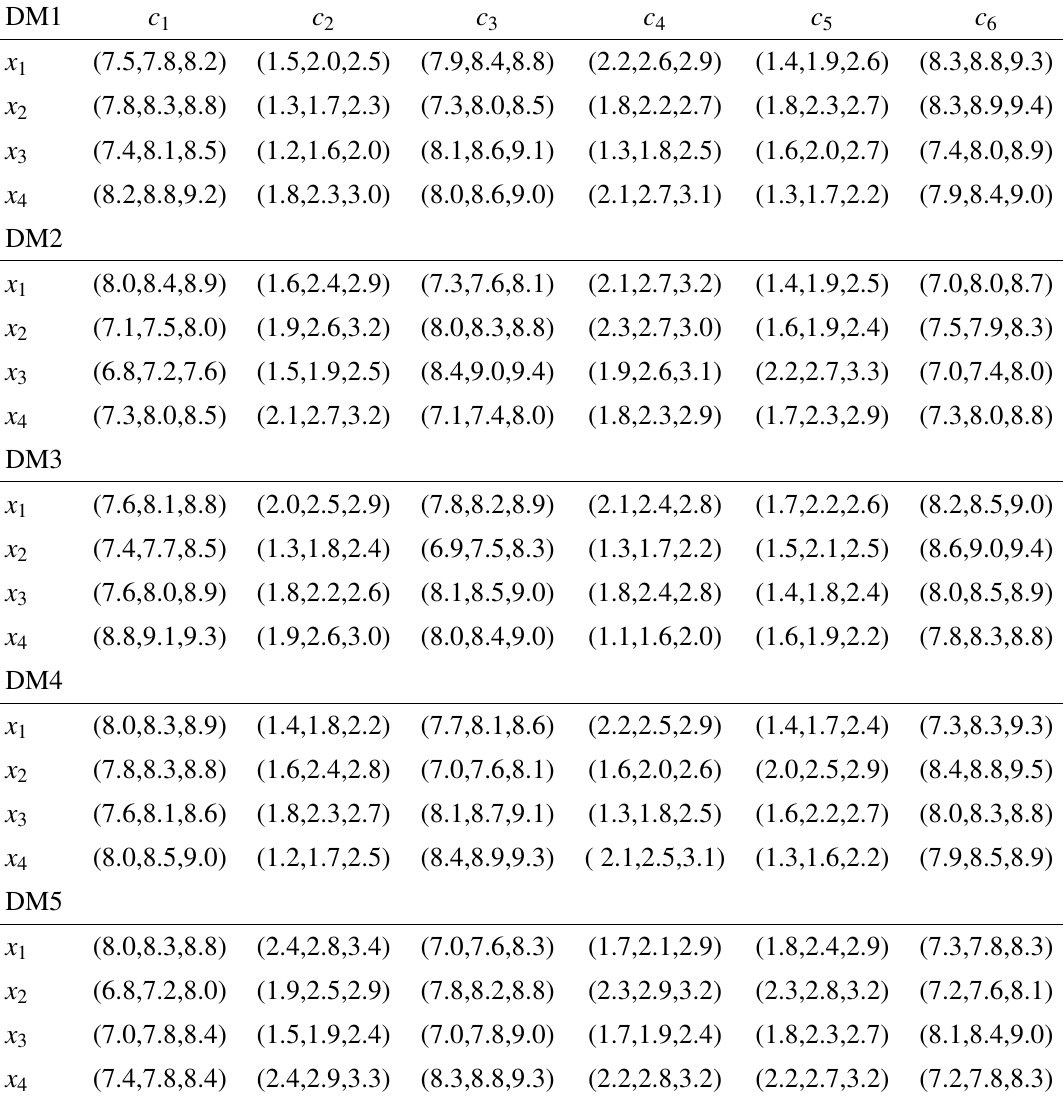
Table 2: Initial decision matrix given by